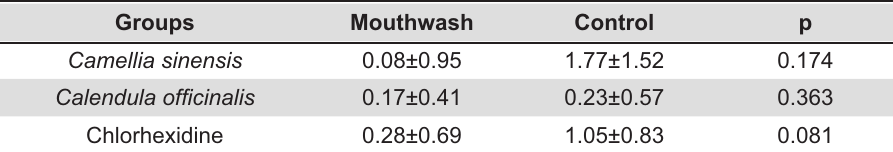
) of microorganisms isolated from 10